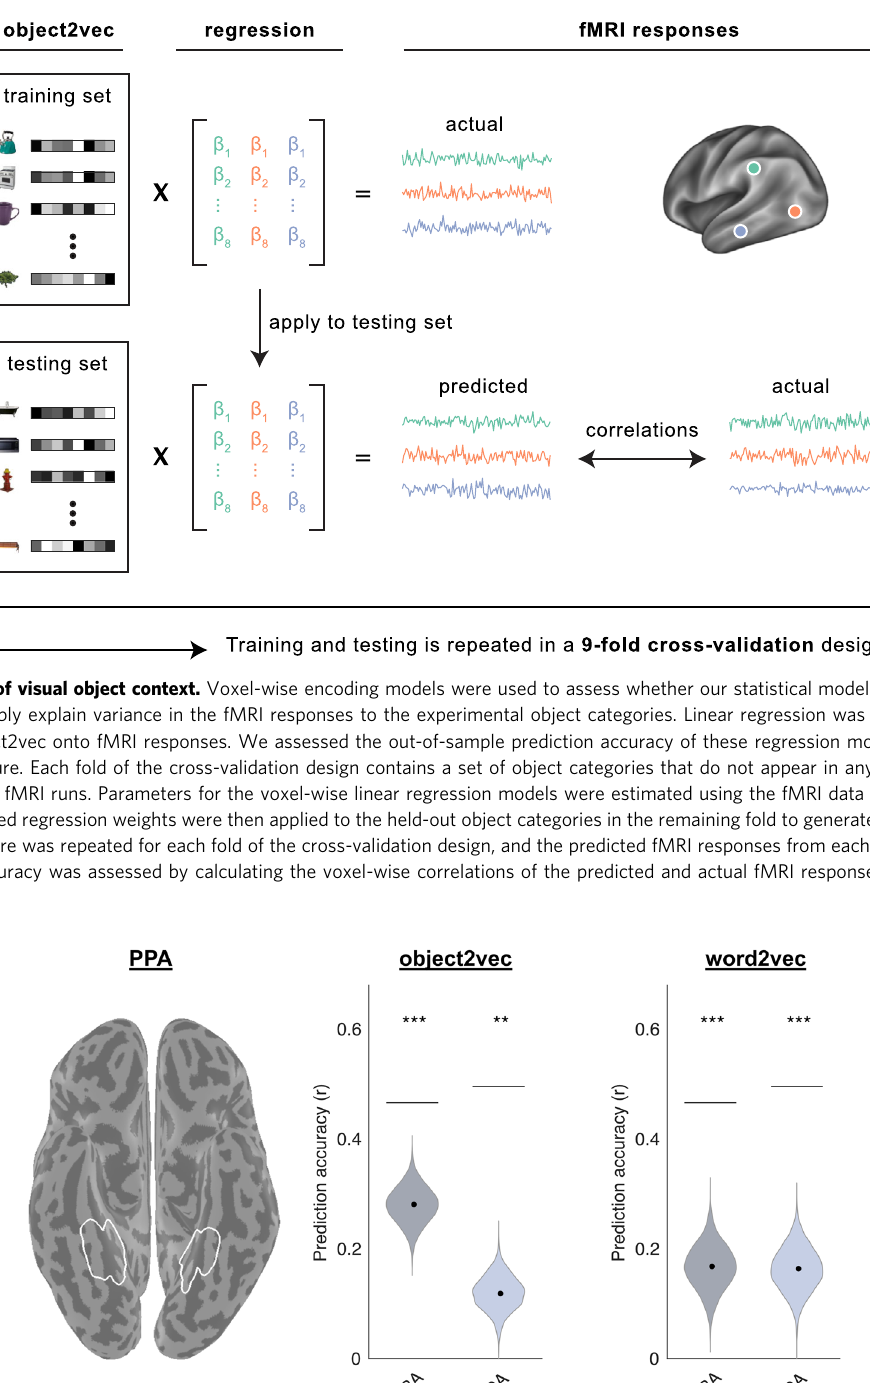
NATURE COMMUNICATIONS| (2021) 12:4081 |https://doi.org/10.1038/s41467-021-24368-2|www.nature.com/naturecommunications